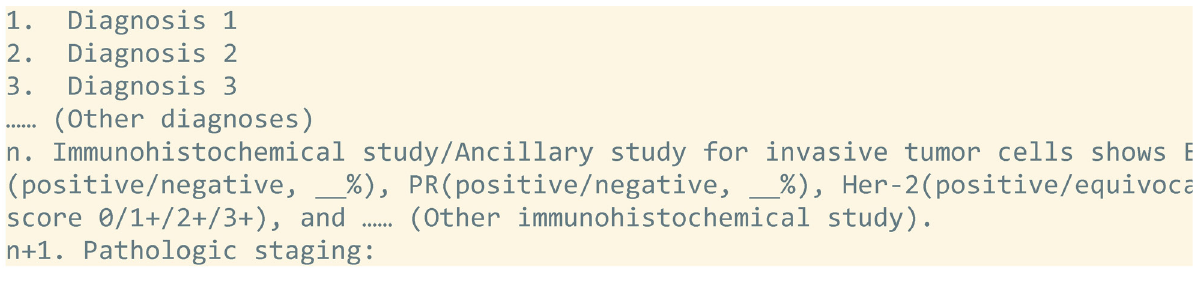
Figure 6: Reporting immunohistochemical study result as a sentence in the microscopic